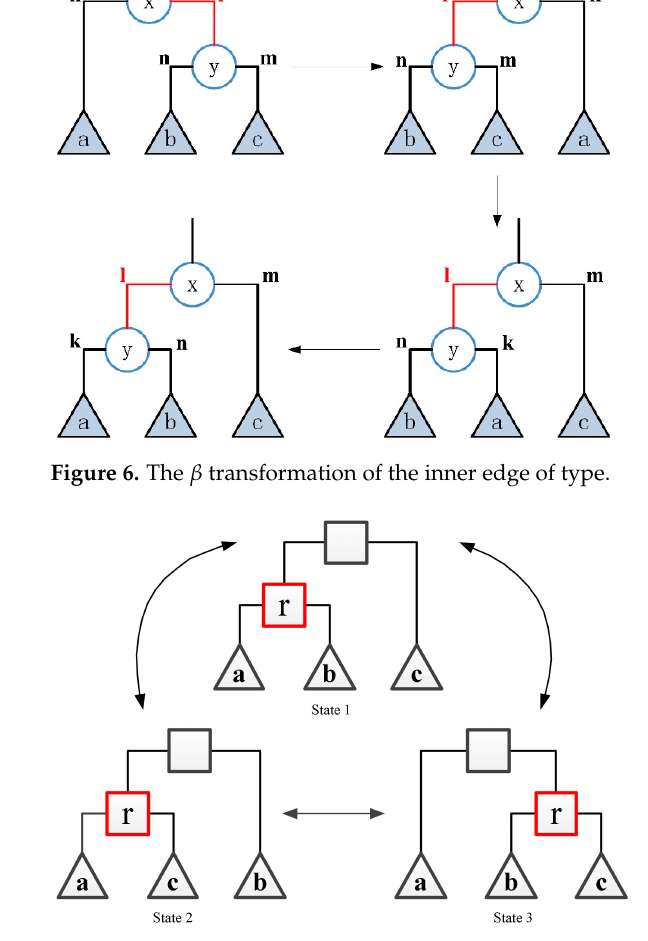
Figure 7. Subtree rearrangement, starting from any one state, can be converted into the other two